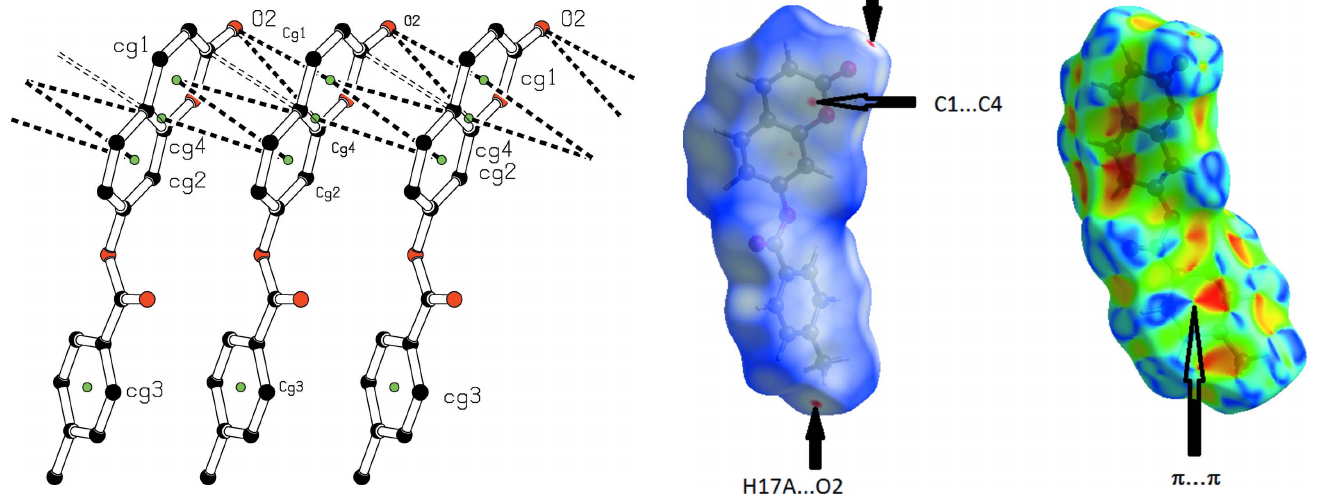
Figure 2 A view of the crystal packing, showing C (cid:3)(cid:3)(cid:3) C contacts, C1 O2 (cid:3)(cid:3)(cid:3) (cid:2) and (cid:2) – (cid:2) stacking interactions (dashed lines). The green dots are ring centroids.